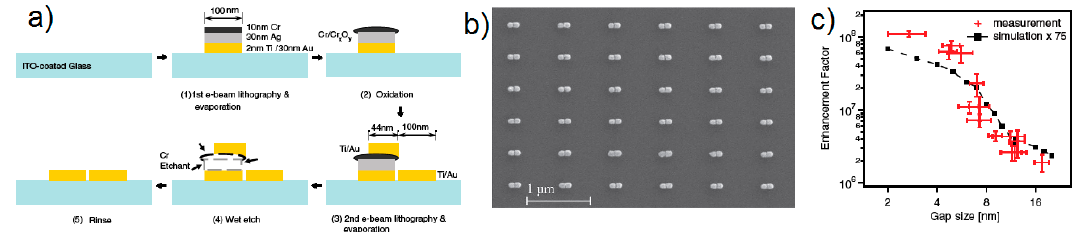
Figure 35. ( a ) Fabrication process for sub 10 nm gaps; ( b ) SEM image of the array of dimers fabricated; ( c ) experimental and theoretical SERS enhancement as a function of the gap. Reproduced with permission from Zhu et al. [43]. Copyright (2011), John Wiley and Sons.